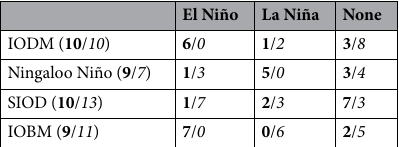
El Niño La Niña